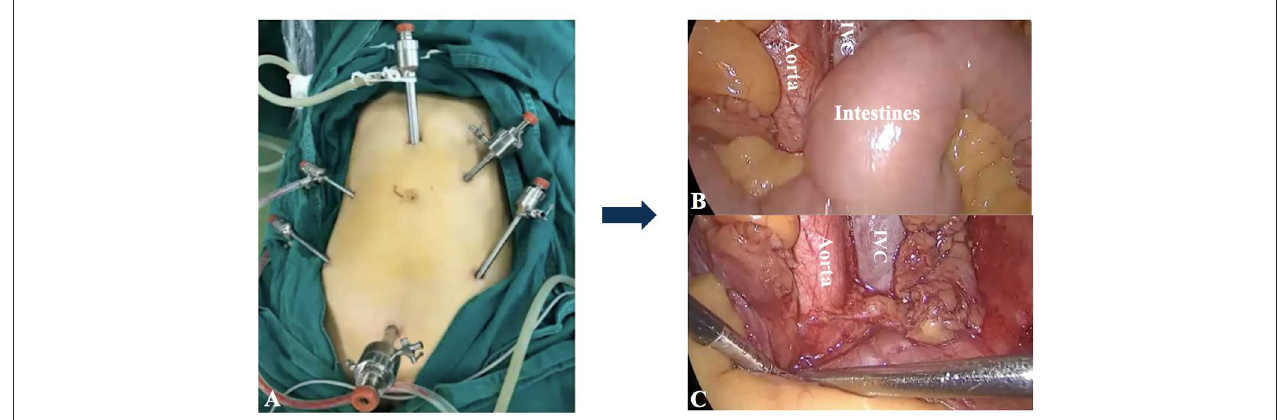
FIGURE 1 | The transperitoneal approach for PALN. (A) The placement of trocars. It was difficult to achieve adequate exposure of para-aortic regions for PALN because of the interference of intestines (B,C) . IVC: Inferior vena cava.